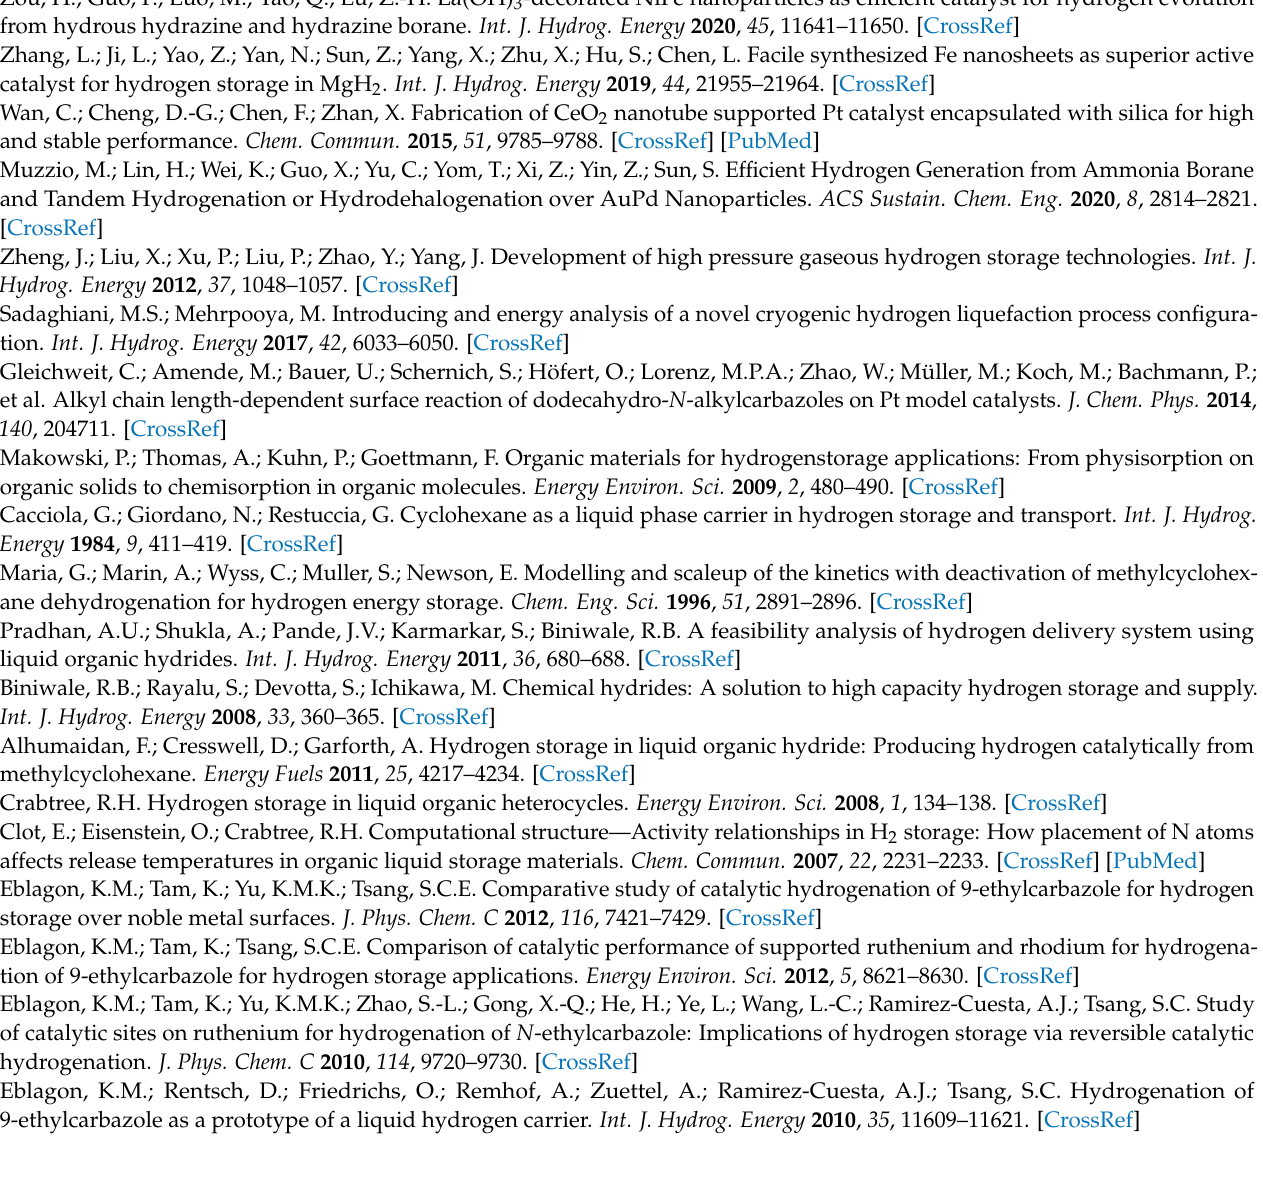
Figure S18: 1 H NMR after catalytic dehydrogenation of BBC – H at 280 ◦